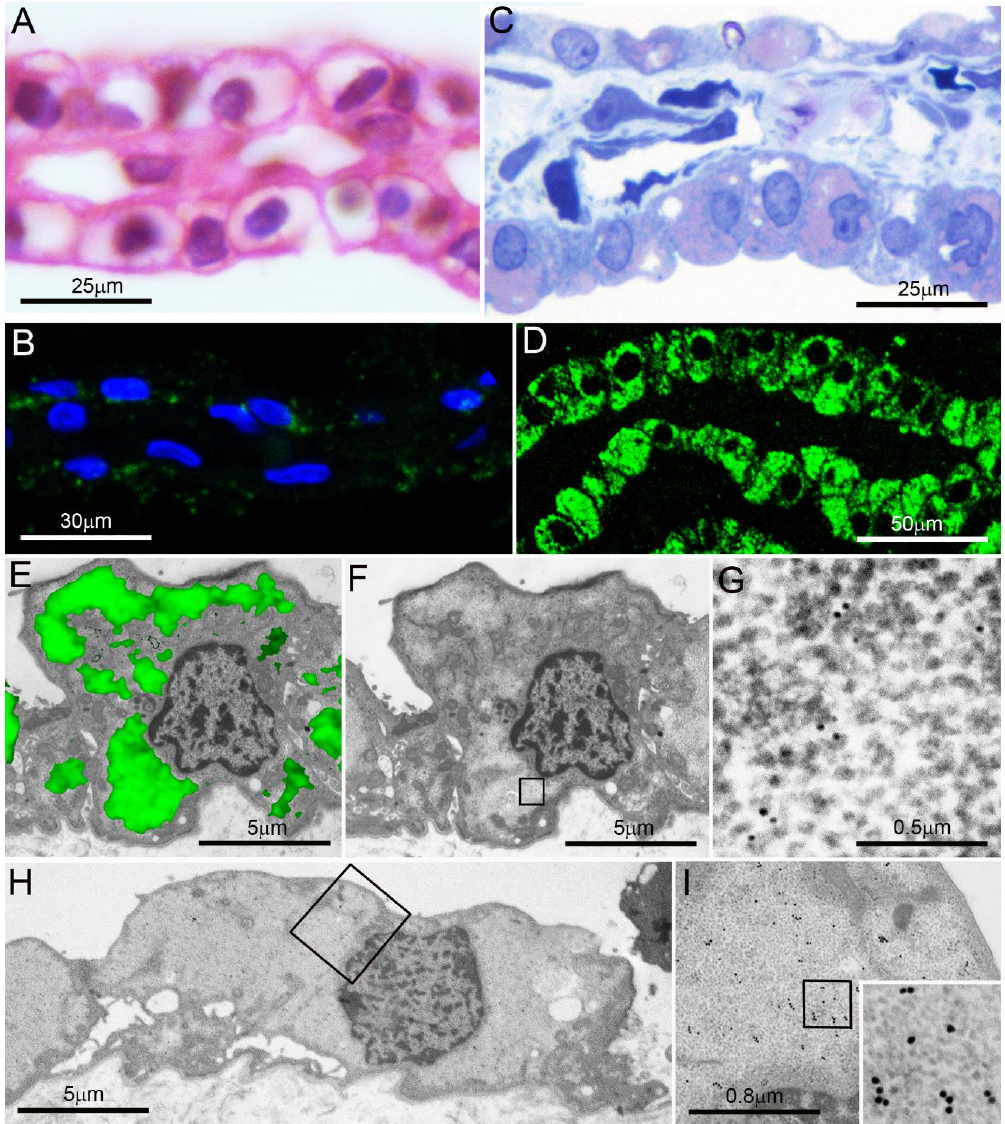
Figure 3. Pancreatic serous microcystic neoplasm. ( A , B ) Formalin-fixed paraffin sections; note the clear, apparently “empty” cytoplasm of most cells in ( A ) (hematoxylin-eosin) and their poor reactivity in ( B ) to proteasome immunofluorescence under confocal microscopy (blue: nuclei; green: proteasome). ( C , D ) Semithin, aldehyde – osmium-fixed resin sections from the same tumor as in ( A ) and ( B ) show abundant cytoplasmic PaCSs metachromatically stained pink with toluidine blue ( C ) and extensively proteasome immunofluorescent under confocal microscopy (( D ), green: proteasome). ( E ) Proteasome immunofluorescence (green) of a cell from the same tumor as in ( A – D ) is overlapped over its TEM micrograph (alone in ( F )): note the correspondence of immunofluorescent areas (in ( E )) with clear PaCS areas (in ( F )), a finding in keeping with the 20S proteasome immunoreactive particles found in ( G ) (enlarged from the boxed clear area in ( F )). In ( H ), enlarged in ( I ) and further in its inset (50,000×), PaCS 19S immunoreactive particles fill most cytoplasm in a cell from the same tumor. Reproduced and adapted from Reference [18] under a Creative Commons Attribution (CC BY 4.0) International